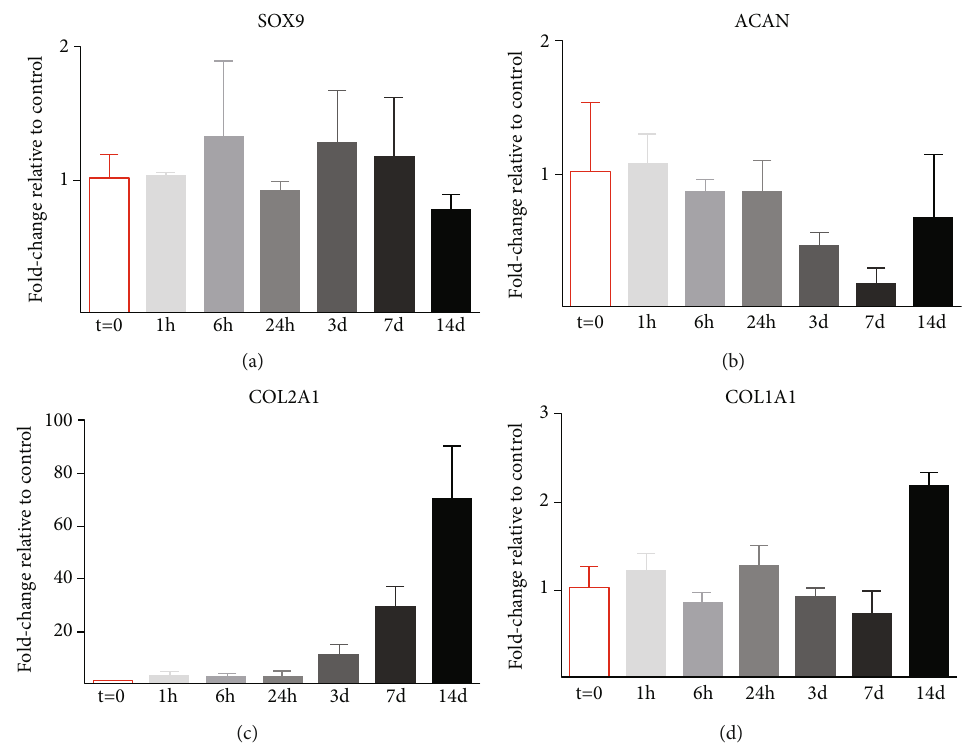
Figure 6: Relative expression of (a) SOX9, (b) ACAN, (c) COL2A1, and (d) COL1A1 genes after 1, 6, and 24 h and 3, 7, and 14 days of chondrogenic di ff erentiation medium culture of hDPSC microtissues. Gene expression was normalized to GAPDH expression and compared to control samples ( t = 0 ). Mean ± SD are shown. Statistical signi fi cance at ∗ p ≤ 0 : 05 with respect to